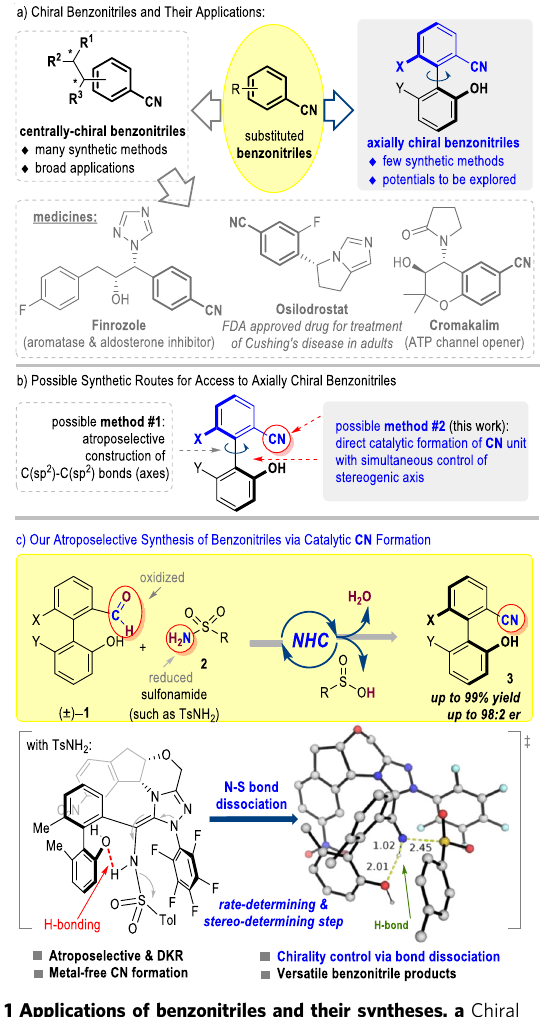
Fig. 1 Applications of benzonitriles and their syntheses. a Chiral benzonitriles and their applications. b Possible synthetic routes for access to axially chiral benzonitriles. c Our atroposelective synthesis of benzonitriles via catalytic CN